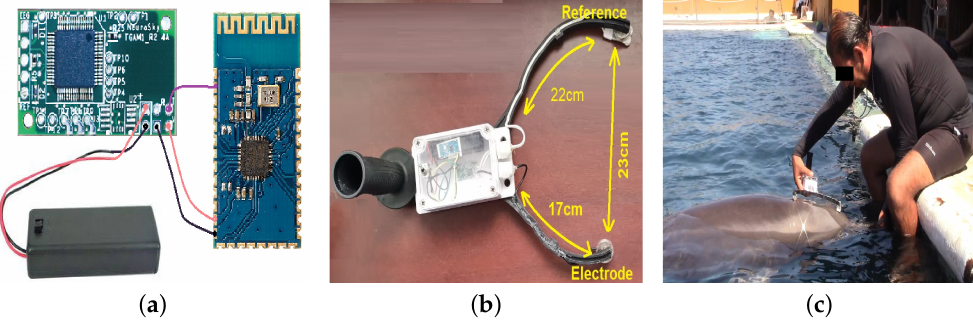
Figure 1. Design of EEG signal capture device adapted for a female bottlenose dolphin. ( a ) ThinkGear ASIC Module EEG Sensor (TGAM1). ( b ) EEG signal capture device. ( c ) Dolphin training for accepting the